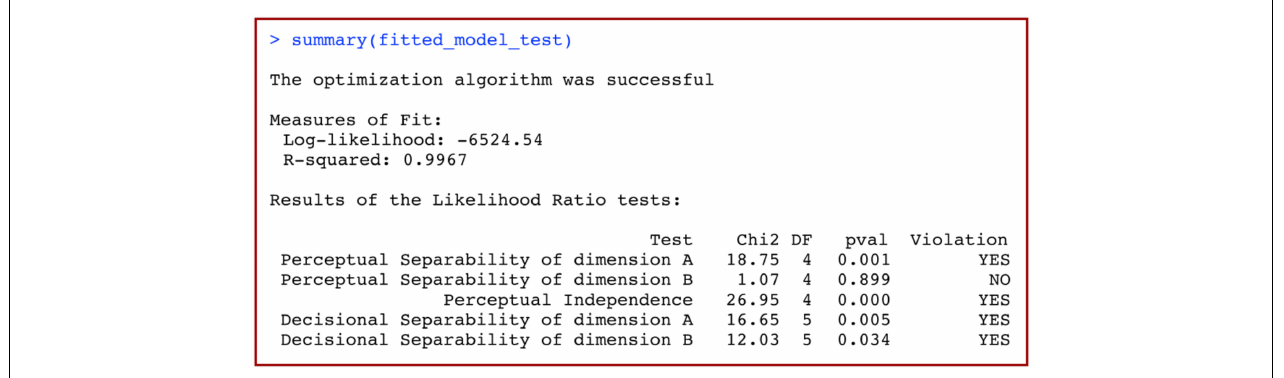
FIGURE 9 | Summary of the results of a model-based analysis of data from a 2 × 2 identification task using general recognition theory with individual differences